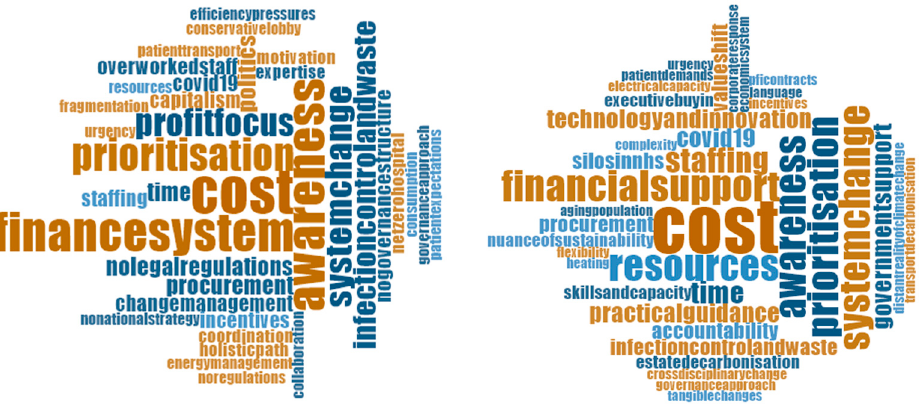
Figure 3. Word clouds of key challenges in Germany and the UK.